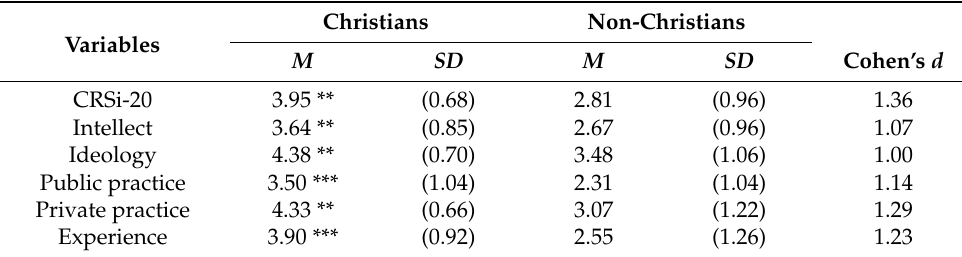
Table 6. Comparison of centrality of religiosity between selected LGBTQ Christians and non- Christians . Variables